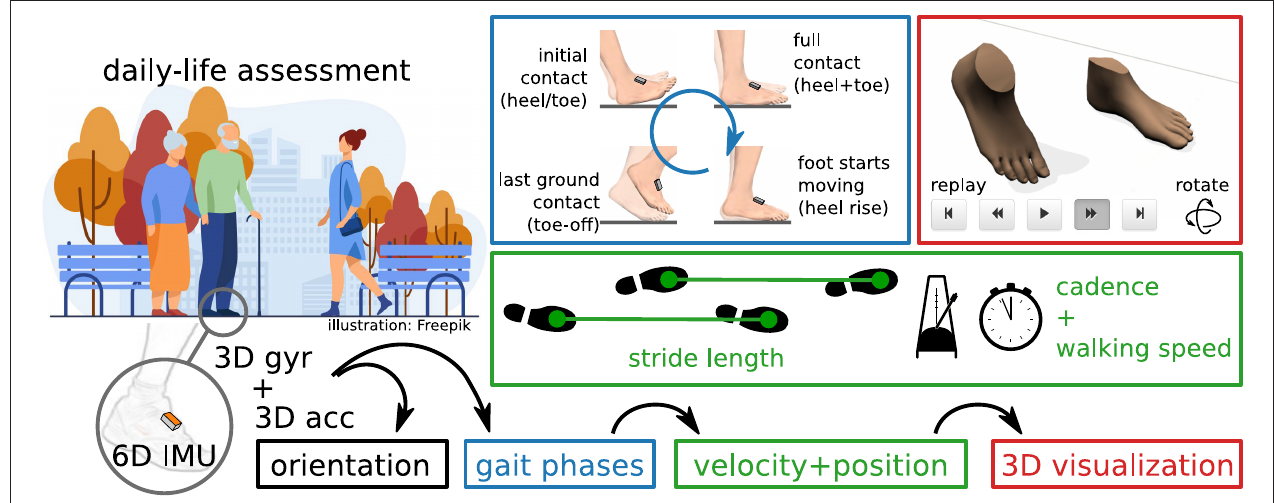
FIGURE 1 | Inertial gait analysis can be realized with two miniaturized IMUs on the shoes, enabling daily-life assessment outside of laboratory environments. From the raw sensor data, orientation, gait phases, and velocity and position trajectories can be estimated. Parameters commonly used in gait analysis, such as stride length, cadence, and walking speed, can easily be derived from this.